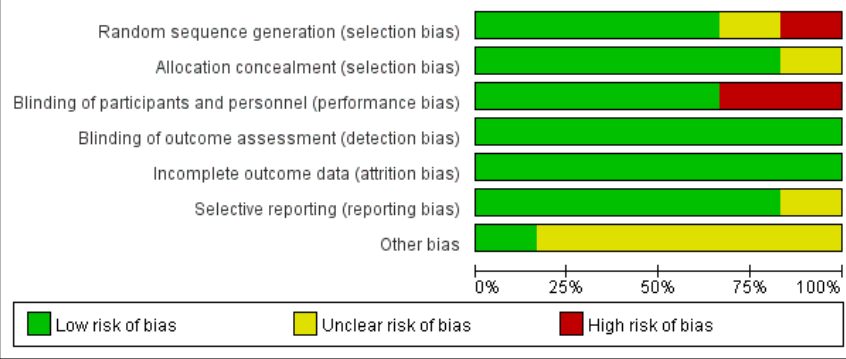
Figure 3. Quality Assessment of the Included Studies.